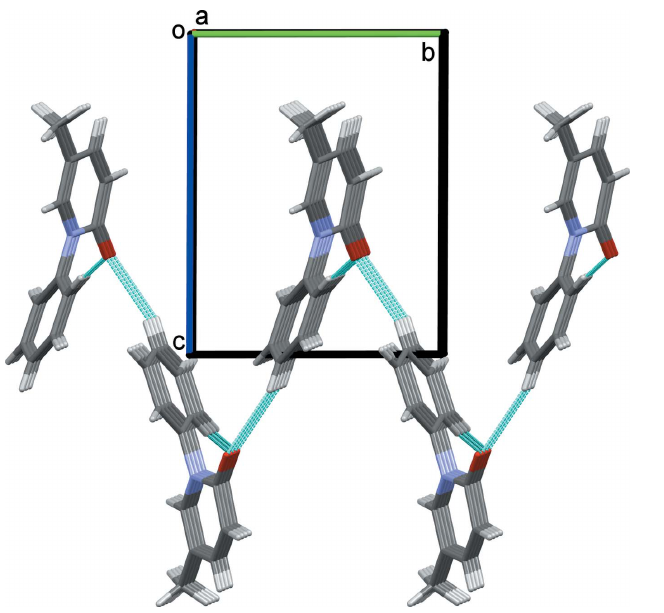
Figure 3 A view along the c axis of the crystal packing of pirfenidone. The C— H (cid:3)(cid:3)(cid:3) O hydrogen bonds (see Table 1) are shown as dashed lines.